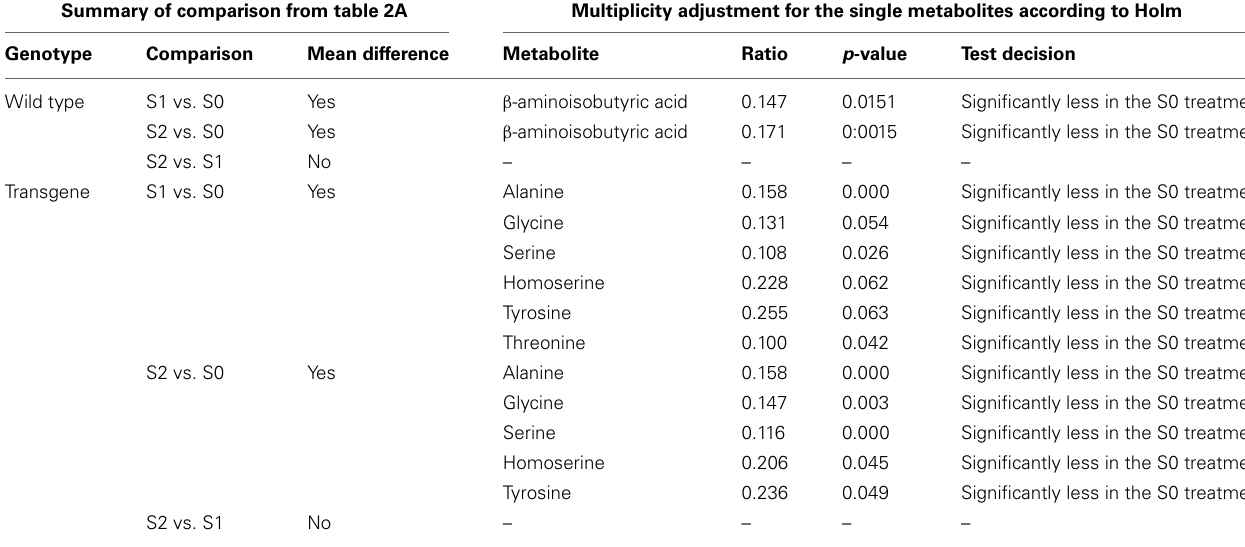
Table 2B | Testing the influence of variable sulfur fertilization rates on single metabolites. Summary of comparison from table